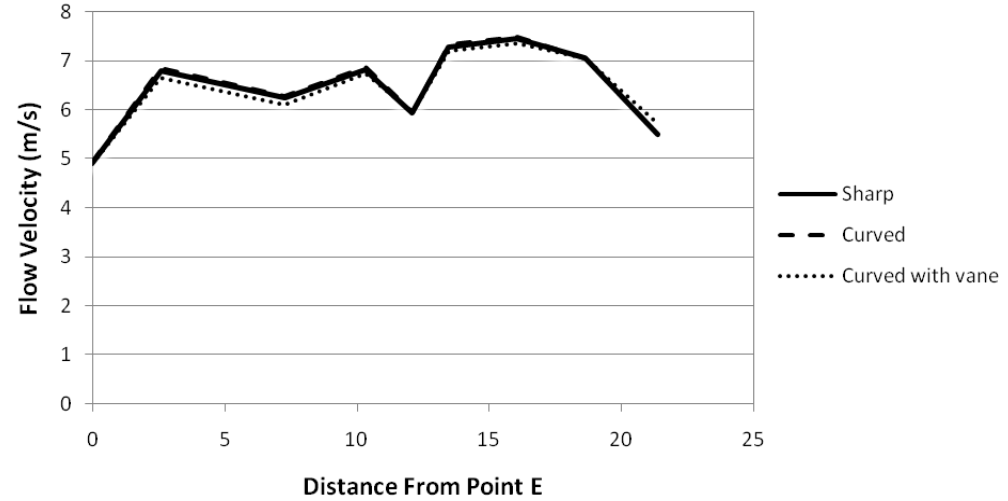
Figure 18. Flow velocity variation along C-Ss for HDS scenario (at monitoring points).